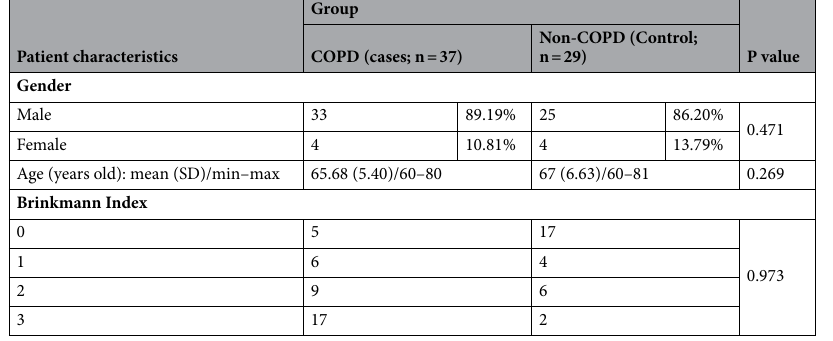
Table 1. Basic characteristics of COPD patients and non-COPD individuals.